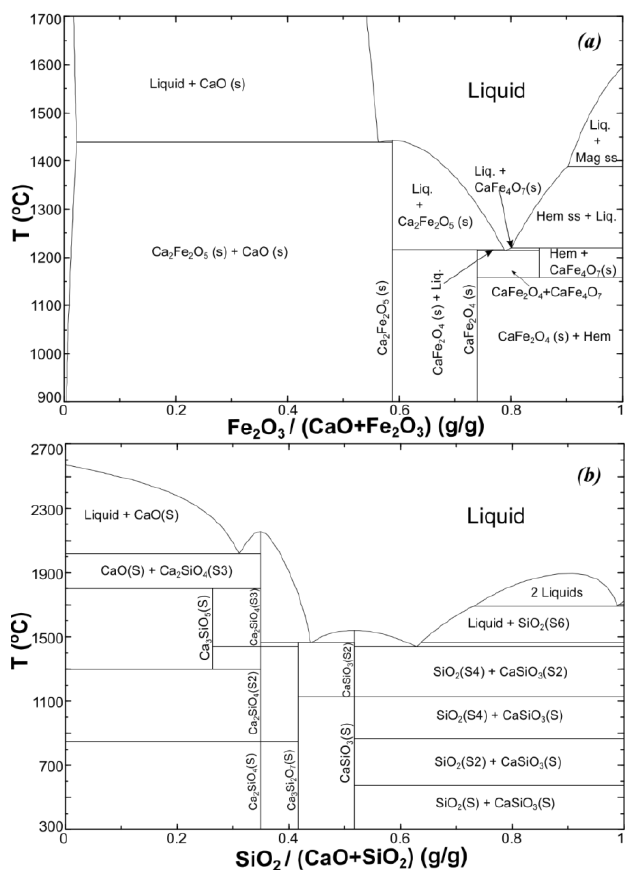
Figure 10. ( a ) Predicted CaO-Fe 2 O 3 in air. ss = solid solution, Hem = hematite, Mag = magnetite; ( b ) calculated CaO-SiO 2 phase diagram employing TECs. The corresponding experimental phase diagrams can be found elsewhere [70,71].